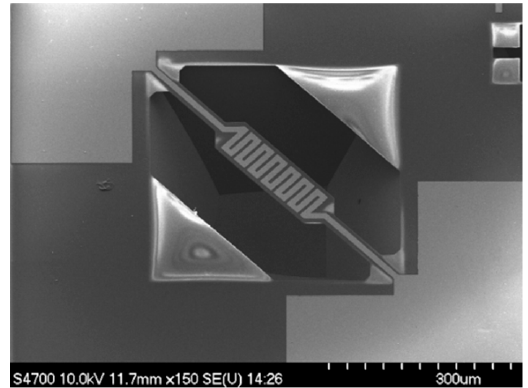
Figure 1. Silicon micro-hotplate [34].